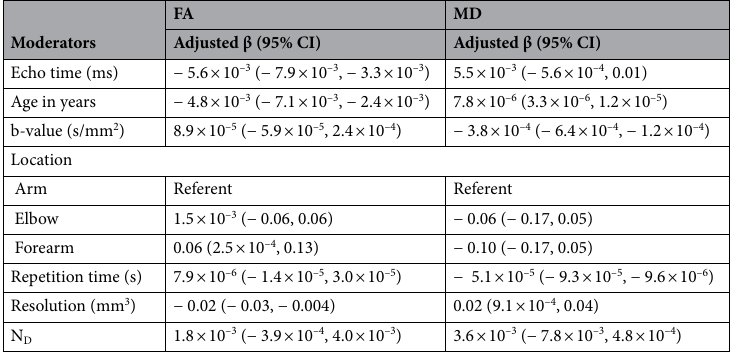
Table 1. Multivariable meta-regression of factors associated with FA and MD. N D = the number of diffusion encoding gradient directions. Note that each variable has been differently adjusted, as defined by our DAGs (http:// dagit ty. net/ mcgJv h9, eFigs.